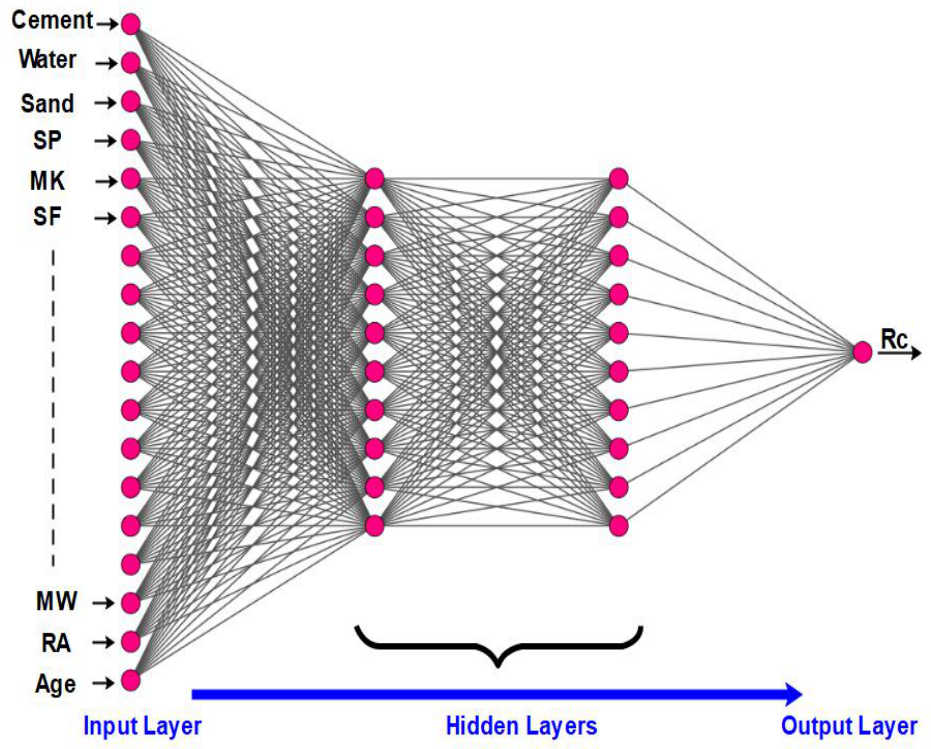
Figure 6. Architecture of the artificial neural network in this study.